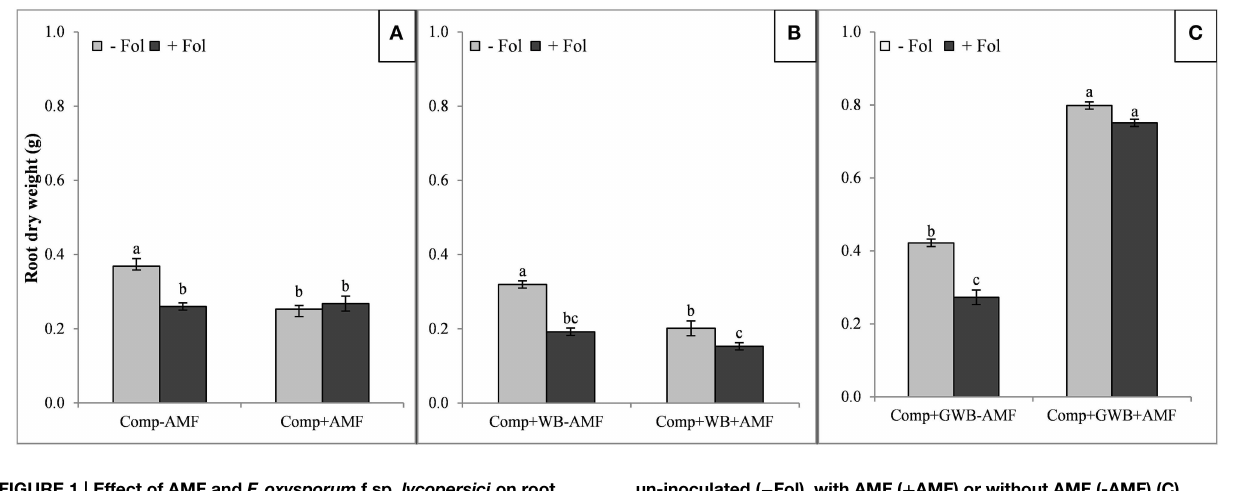
FIGURE 1 | Effect of AMF and F. oxysporum f.sp. lycopersici on root dry weight of tomato plants grown in different soil substrates, (A) comprising of compost (Comp) inoculated ( + Fol) or un-inoculated ( − Fol), with AMF ( + AMF) or without AMF ( − AMF) (B) combination of compost and wood biochar (Comp + WB), inoculated ( + Fol) or